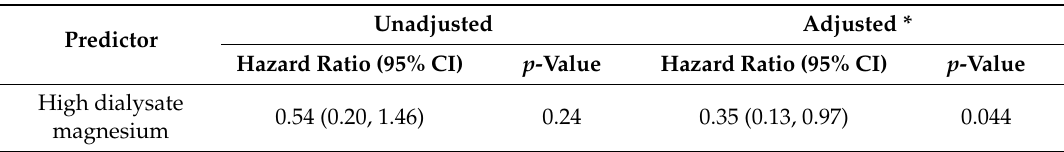
Figure 1. Box plot with median and interquartile range differences in ionized serum magnesium concentration in patients on low (0.50 mmol/L) and high (0.75 mmol/L) dialysate magnesium concentration, collected before a midweek dialysis session at study entry. IQR, interquartile range. Table 2. Univariate and adjusted hazard ratios of high dialysate magnesium for all-cause mortality risk. Unadjusted Adjusted * Predictor Hazard Ratio (95% CI) p -Value Hazard Ratio (95% CI) p -Value High dialysate * Adjusted for age and CCI. CI, confidence